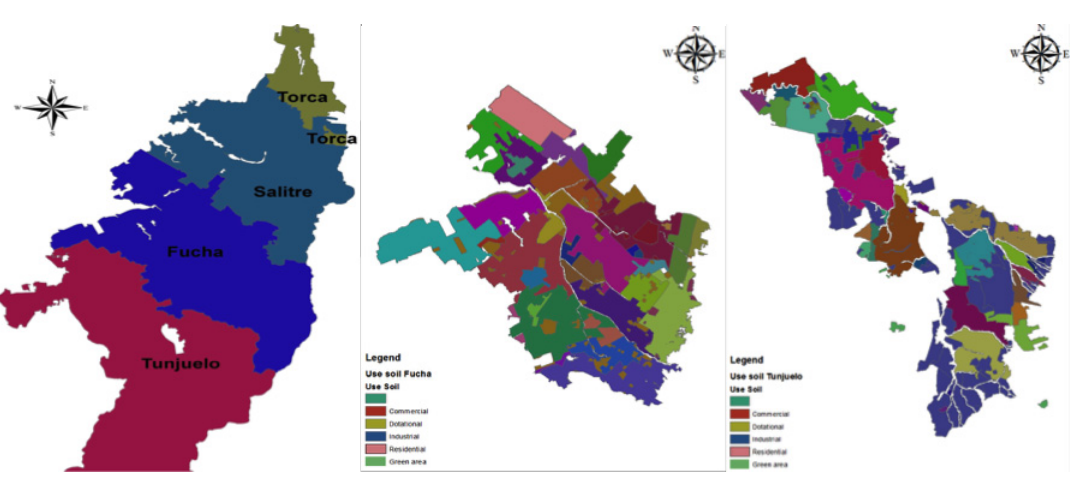
Figure 1. Land use of Fucha and Tunjuelo Catchments.